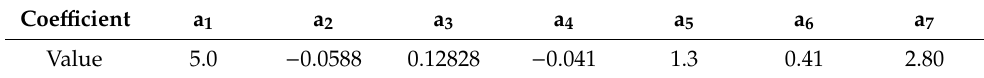
Table 2. Regression coe ffi cient in deformation resistance model.